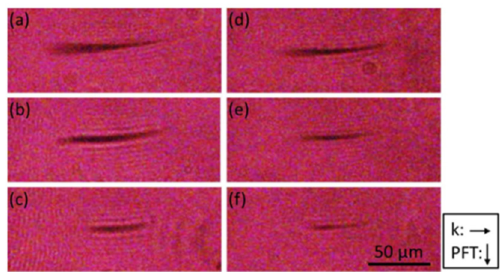
Figure 10. Time ‐ resolved shadowgraphs of transient plasma induced by SSTF pulses inside fused silica glass. The polarization direction of the femtosecond laser pulse is parallel to spatial chirp in ( a – c ) and perpendicular to spatial chirp in ( d – f ). The pulse energies are 6 μ J in ( a , d ); 4 μ J in ( b , e ); and 2.5 μ J in ( c , f ), respectively. The direction of laser propagation ( k ) and the PFT are indicated by the arrows in the lower panel of the figure. Reproduced with permission from [26], Copyright The Optical Society, 2015.